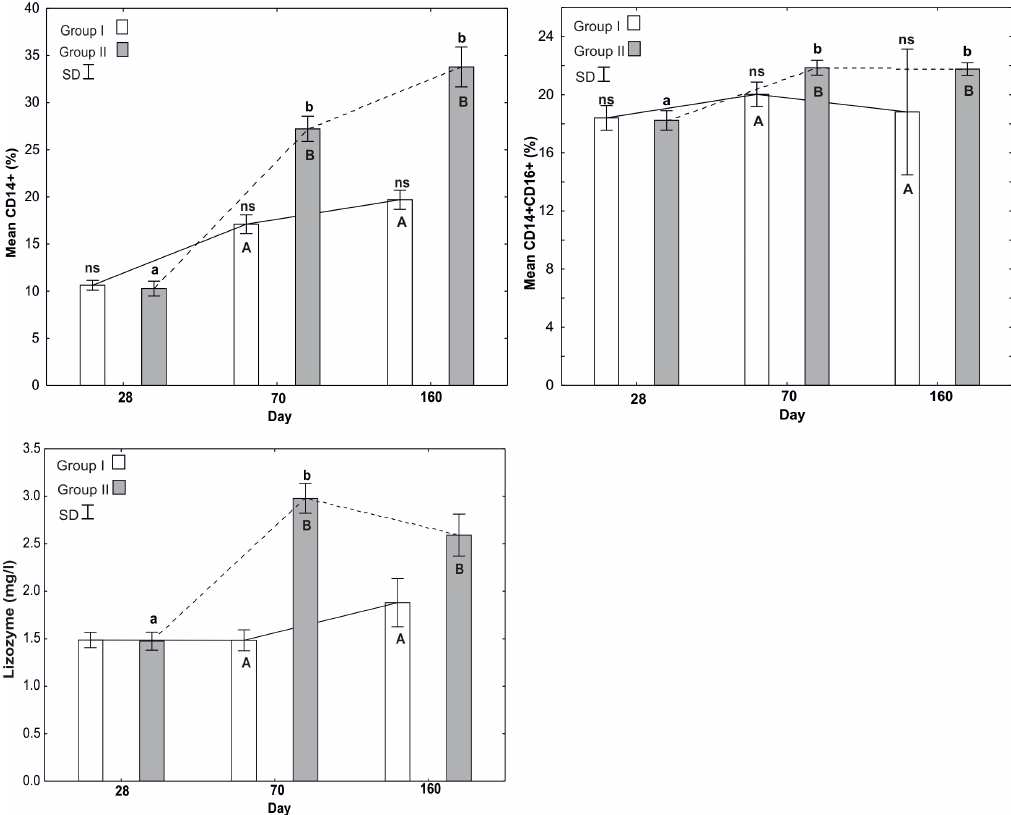
Figure 2. Percentages of CD14 + and CD14 + CD16 + cells and the lysozyme concentration in the peripheral blood of pigs. Values are expressed as mean and standard deviation ( α ± SD). One-way ANOVA